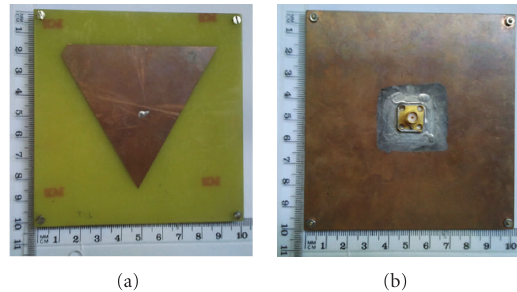
Figure 7: Developed 1.176 GHz antenna: left-radiation face, right- ground face with 3mm Via.